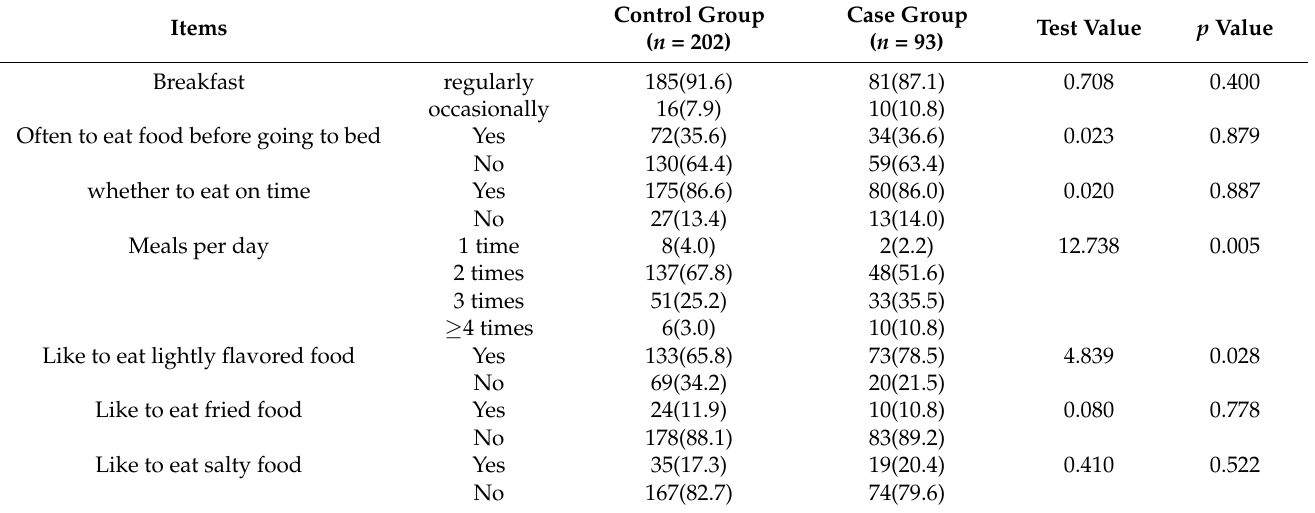
Table 8. Comparison of the eating and drinking habits of women during pregnancy between the control and case groups ( n ,